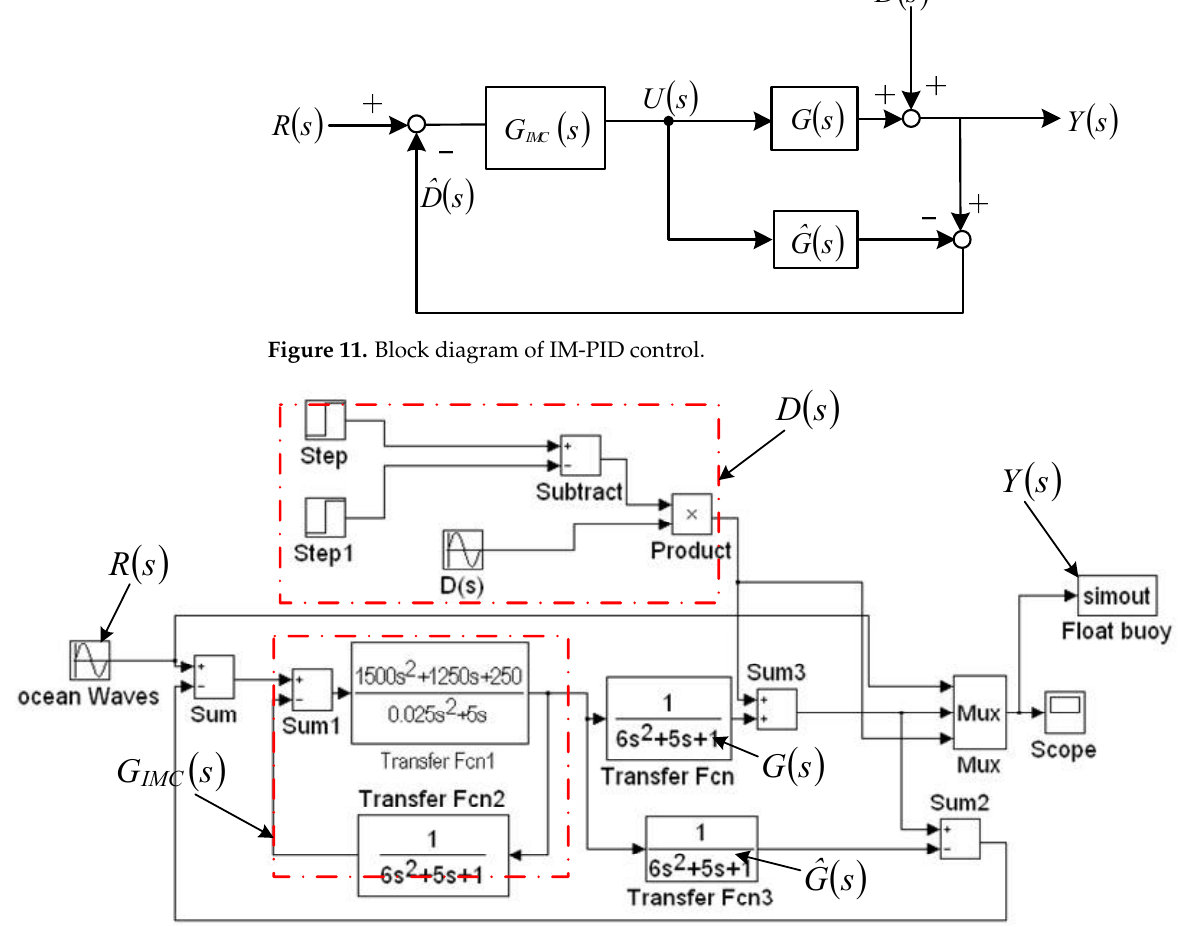
Figure 12. Simulation model of ocean wave power generation system based on the IM-PID control.